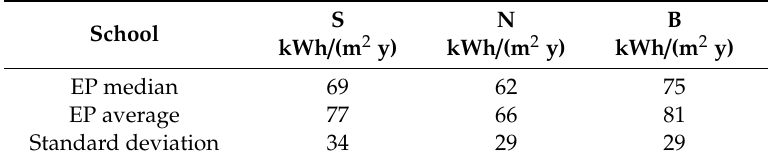
Table 6. Results of 25 simulations. E SH and E DHW presents by thermal energy. The area m² in the table refers to A temp .